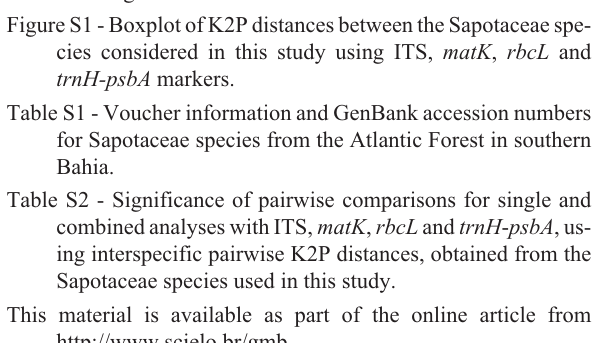
Table S2 - Significance of pairwise comparisons for single